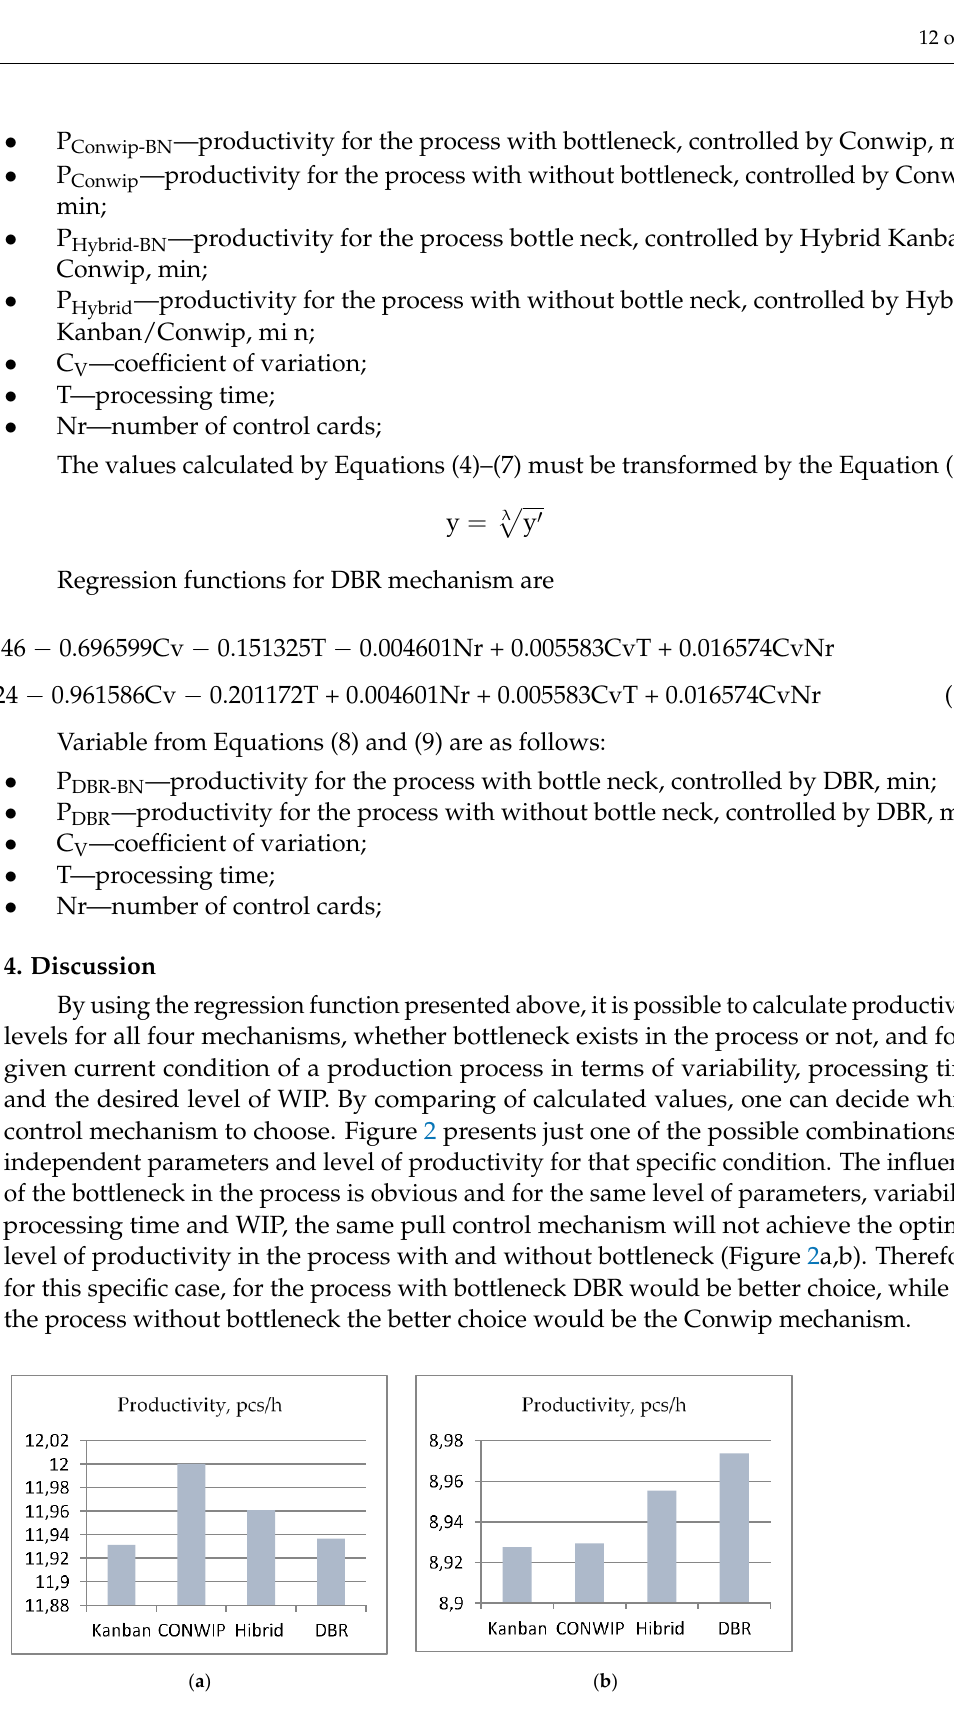
Figure 2. Comparison of effectiveness of pull control mechanisms ( a ) Productivity for set of parameters: za Cv = 0.25, T = 5 min, WIP = 15, for the process without bottleneck ( b ) Productivity for set of parameters: za Cv = 0.25, T = 5 min, WIP = 15, for the process with bottleneck.